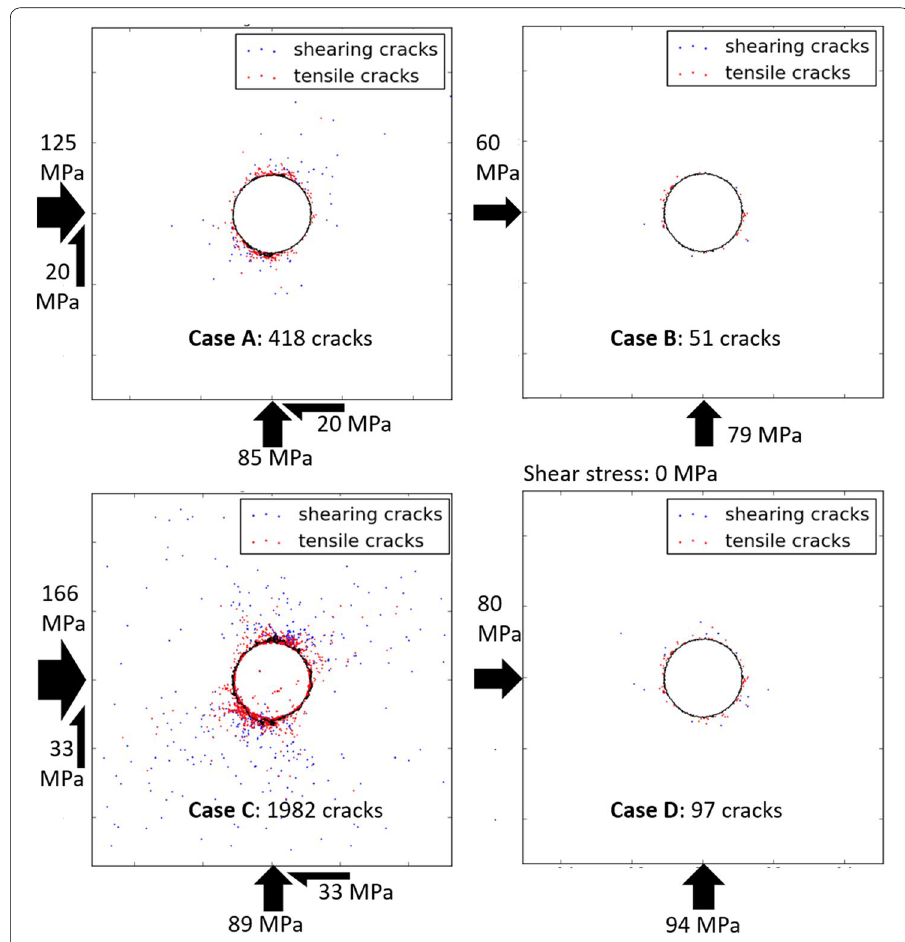
Fig. 10 Results of simulations, after drilling, for the four stress states (see "Numerical approach" section for definition of cases A, B, C and D). Each red point corresponds to the apparition of a tensile crack, each blue point corresponds to the occurrence of a shearing crack. The total number of cracks is mentioned in each subplot. The field of view for each subplot is 1 m